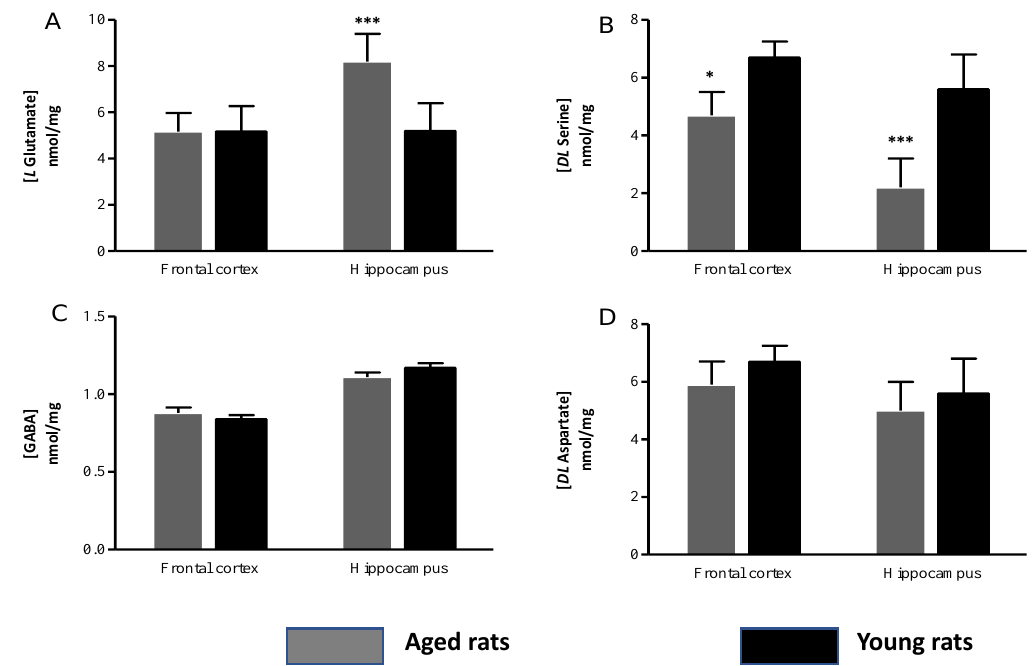
Figure 4. Effect of aging on amino acid concentration in the examined brain areas. ( A ) L Glutamate, ( B ) DL Serine, ( C ) GABA, ( D ) DL Aspartate. *** ( p < 0.001); * ( p < 0.05) corresponds to significant differences between experimental groups.